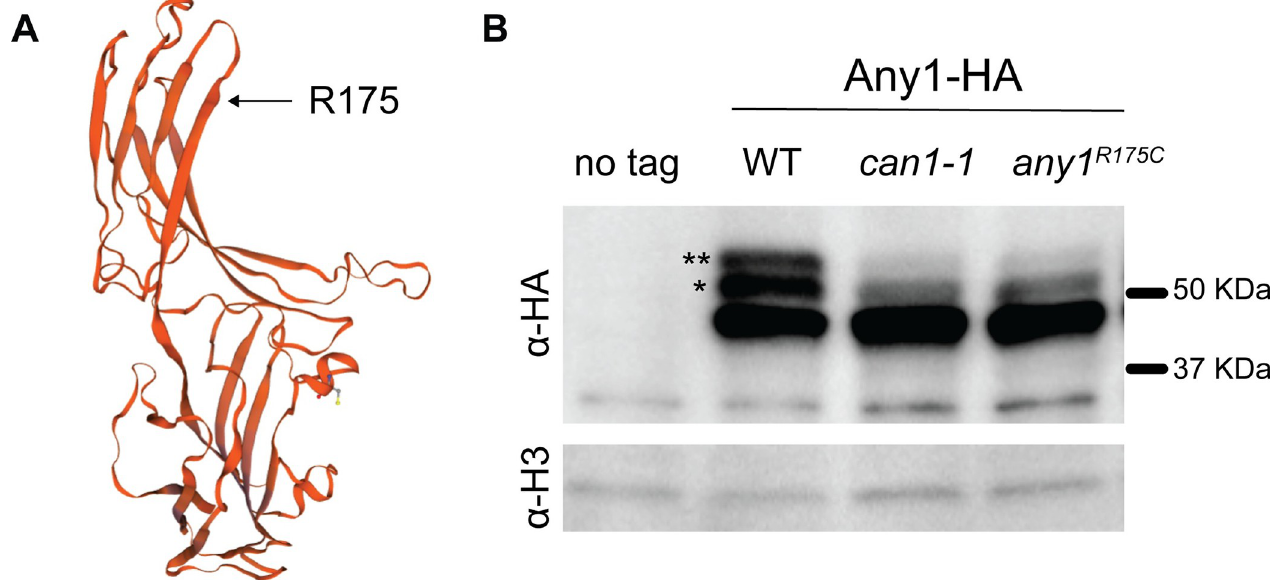
Fig 4. Effect of the any1-523C > T mutation at the protein level. A. Automated protein structure prediction using homology modeling (SWISSMODEL). Expression of any1-523C > T leads an arginine to cysteine substitution at position 175. B. Expression of WT and mutated Any1 ( can1-1 and Any1-R175C) analyzed by immunoblotting the endogenously tagged Any1 with anti-HA. Histone H3 is shown as a loading control. The asterisks correspond to the post- translationally modified forms of Any1, where � corresponds to an unknown PTM and �� likely corresponds to the Pub1-mediated ubiquitinated form [13]. Both PTMs are strongly diminished in cells expressing Any1 R175C . Strains used: KT1191, KT1391, KT1394,